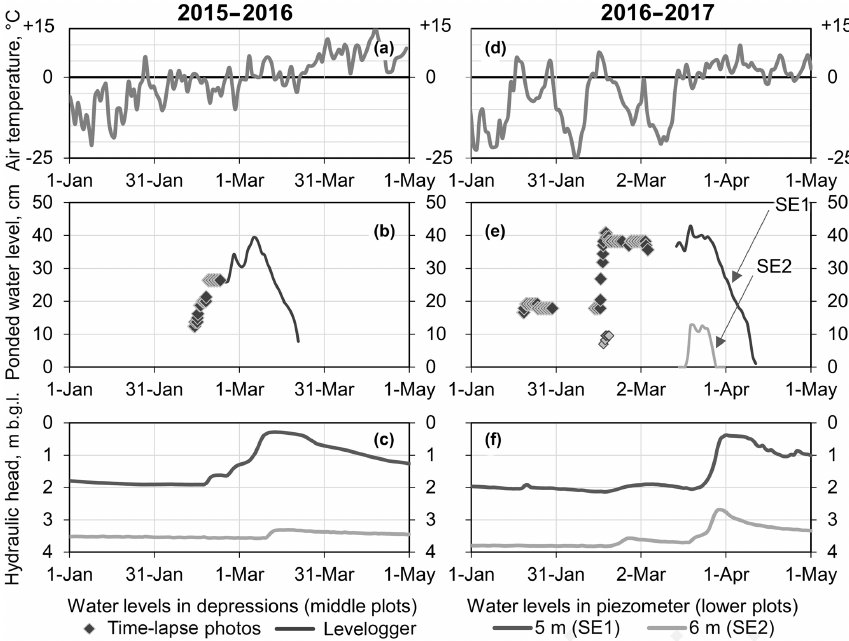
Figure 8. Daily average air temperatures (a, d) , water levels in the depressions (b, e) , and piezometers (c, f) at SE1 depression at the